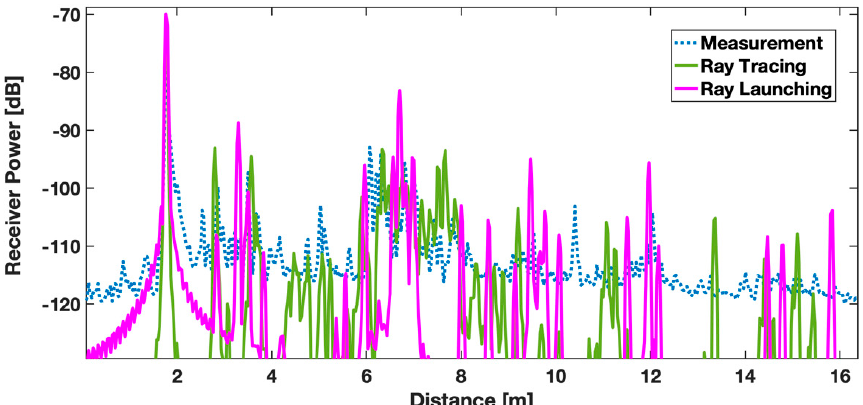
Figure 7. Comparison between the PDP measured at Position 7, simulated with the tracer and simulated with the launcher programmed in GPU.